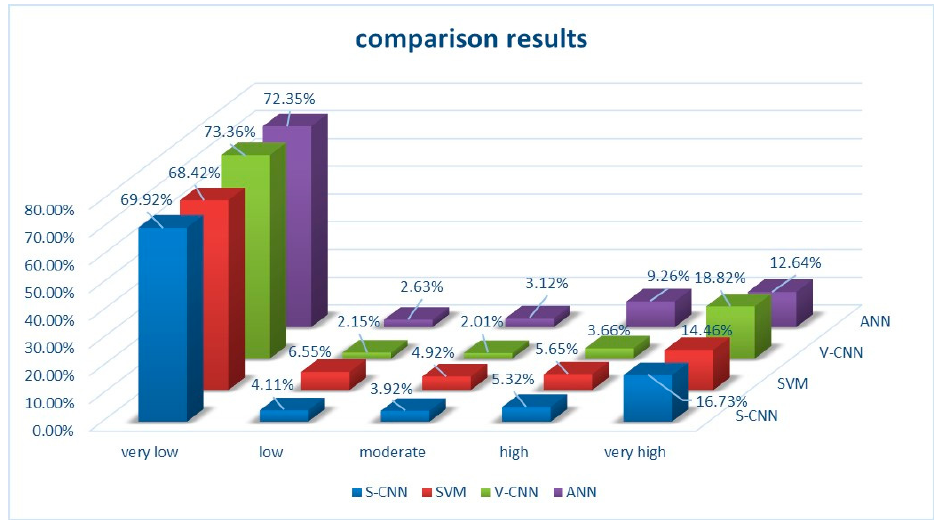
Figure 18. The proportion of the prediction results of different models in the susceptibility level.